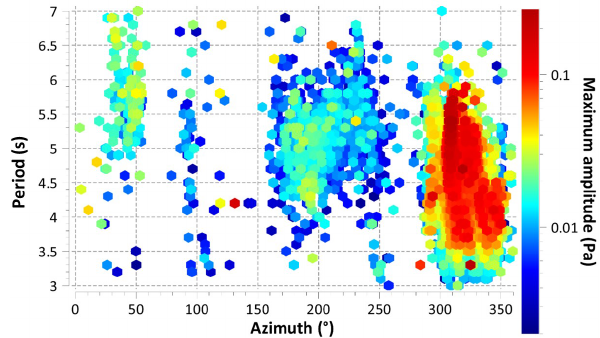
Figure C1. Signal periods versus back-azimuths at IS31 observations in 2017. The amplitude is color coded (in Pa).